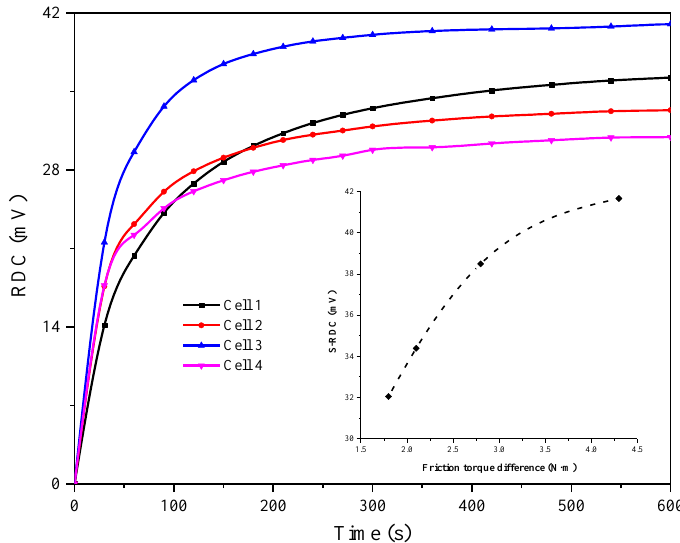
Figure 13. Variation in residual DC voltage with time, in which the inserted graph shows the relation between saturated residual DC voltage and friction torque difference.